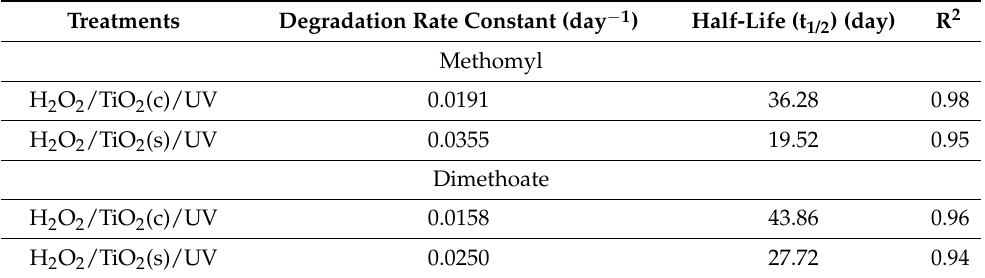
Figure 2. ( 2a ) Liver of control untreated rats, central vein (C), sinusoid (S), and hepatocytes (H); ( 2b ) liver of rats treated with water contaminated with dimethoate after remediation with TiO 2 (s)/H 2 O 2 /UV, hepatocellular vacuolar degeneration (V)’; ( 2c ) liver of rats treated with water contaminated with methomyl after remediation with TiO 2 (s)/H 2 O 2 /UV, (PI) portal mononuclear cell infiltration and hepatocellular vacuolar degeneration (V); ( 2d ) liver of rats treated with water containing TiO 2 (s)/H 2 O 2 without any insecticides, hepatocellular vacuolar degeneration (V). Table 1. Degradation rate and half-life values of the tested insecticides under different irradiation sys-